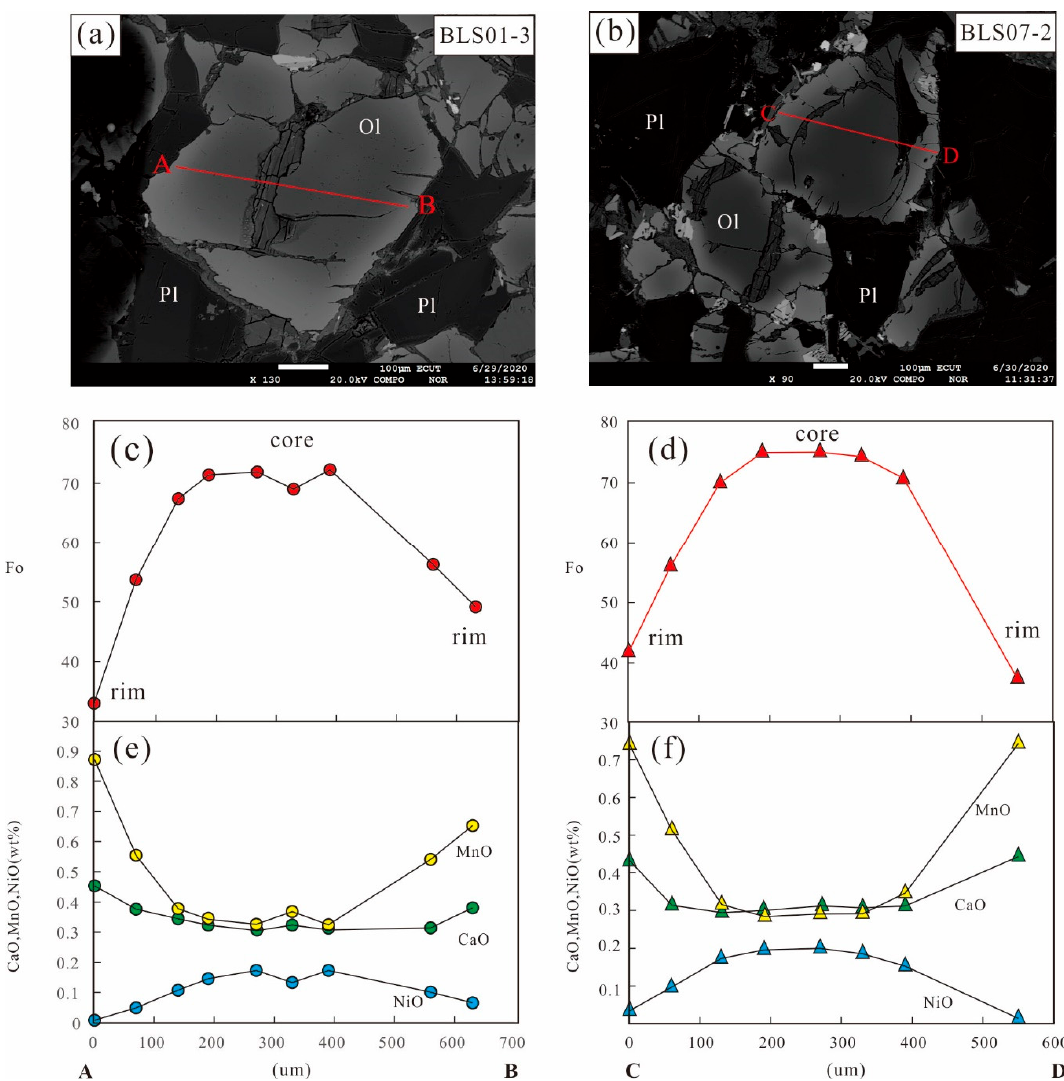
Figure 10. Core-rim compositions of two representative zoned olivine from samples BLS01-3 and BLS07-2 of the Qianjiadian basaltic rocks. Back-scattered electron images show the compositional traverses ( c – f ) marked by red lines ( a , b ). The cores have higher Fo and NiO and lower MnO and CaO content than the rims. Fo = 100 × Mg / (Mg + Fe + Mn). For mineral abbreviations, see Figure 3.